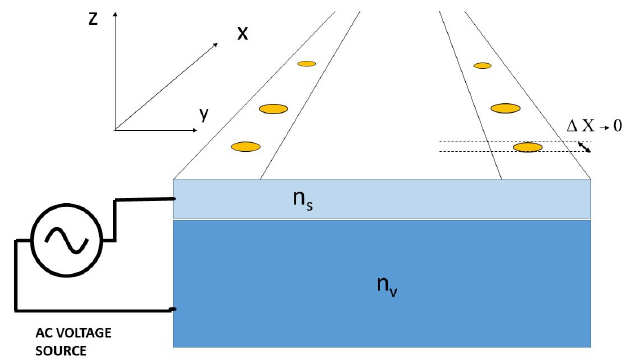
Figure 3. Plasmon circuit to induce electromagnetic amplification or attenuation. In the Fraunhofer diffraction (in the far-field region) analyzed here, in the far-field region, ∆ x determines the possible extent of the source, or pillar, as in cicada wings, here discussed as a punctual